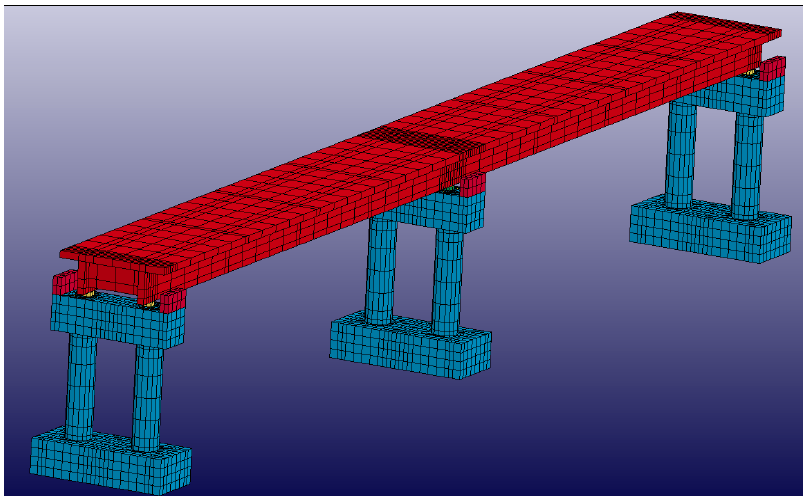
Figure 7. FEA Figure 7. FEA Model. Figure 7. FEA Model.